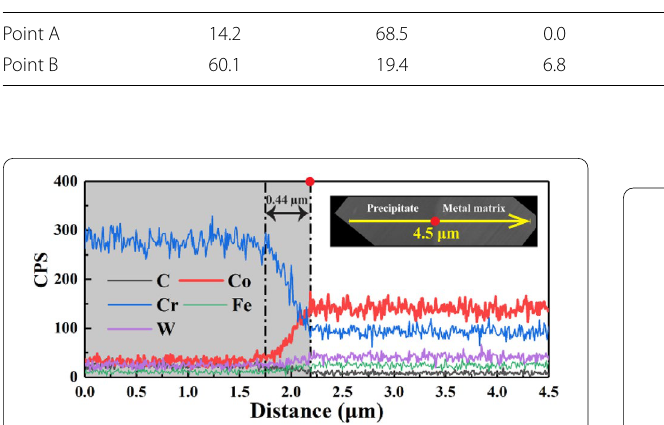
Figure 6 EDX element line from precipitate to metal matrix